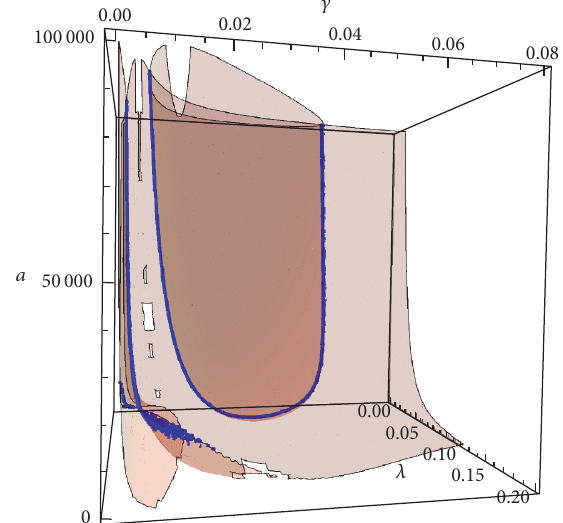
Figure 2:The viewof the plot in Figure 1 along the 𝜆 -axis reveals the variation of 𝛾 with A (symbolized as 𝑎 in the figure).As A increases, the value of 𝛾 asymptotically approaches a fixed value 𝛾 0 (e.g.) of the order of 10 −3 . (See the